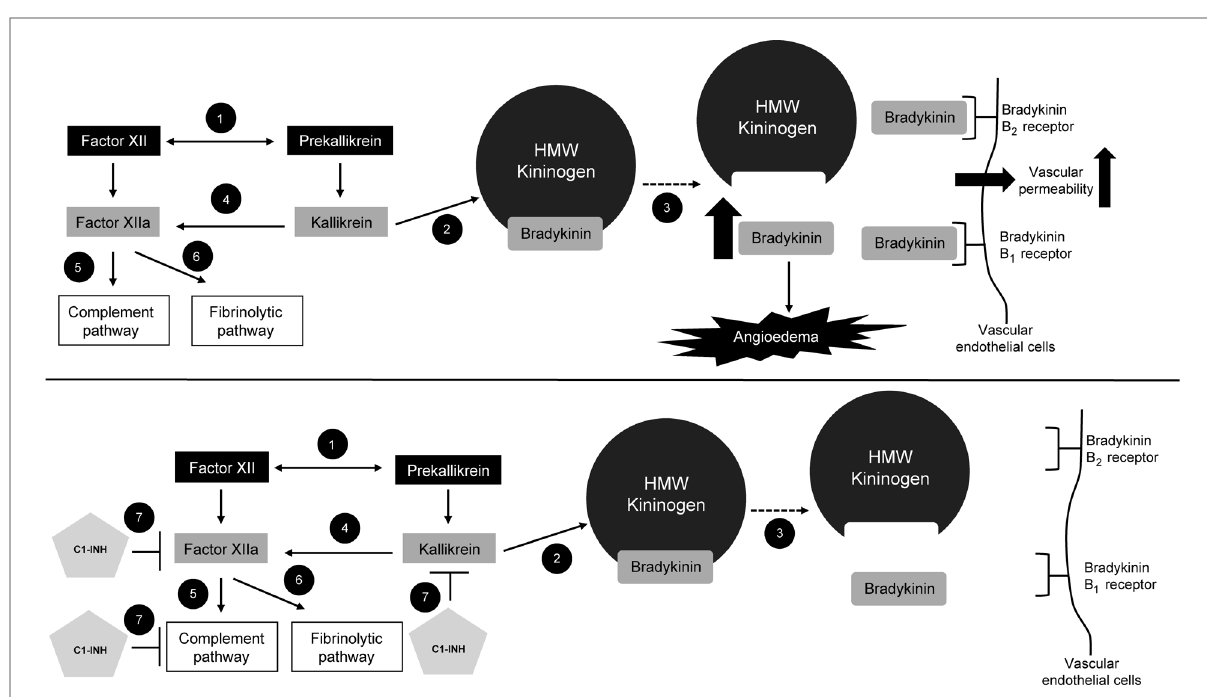
FIGURE 1 Dysregulation of signaling pathways in HAE. (1) When activated by trace amounts of factor XIIa, plasma prekallikrein and factor XII cleave each other to generate kallikrein and factor XIIa. (2) Kallikrein cleaves HMW plasma kininogen, leading to (3) the release of bradykinin. (4) Plasma kallikrein cleaves factor XIIa, leading to (5) activation of complement and (6) fi brinolytic pathways. In the top fi gure, the increase in bradykinin levels results in angioedema. Bradykinin binds bradykinin B 1 and B 2 receptors on vascular endothelial cells, leading to an increase in vascular permeability. In the bottom fi gure, (7) C1-INH inhibits factor XIIa, the complement pathway, and kallikrein, thus leading to a decrease in bradykinin production and reduced activation of bradykinin B 1 and B 2 receptors on vascular endothelial cells. C1-INH, C1 esterase inhibitor; HAE, hereditary angioedema; HMW, high molecular weight . Figure created with data from Cicardi M, et al. J Allergy Clin Immunol Pract. (2018) 6(4):1132 – 41; and Zuraw BL. N Engl J Med. (2008) 359(10):1027 – 36 (5,